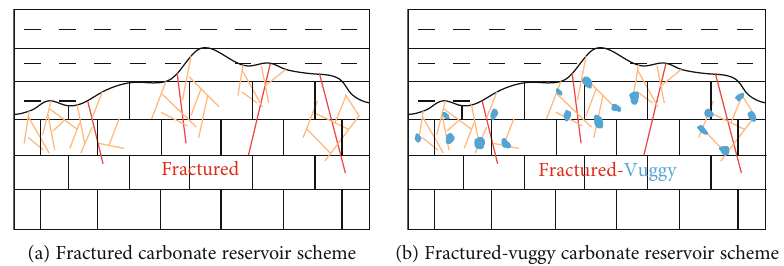
Figure 1: Description of the fractured and fractured-vuggy carbonate